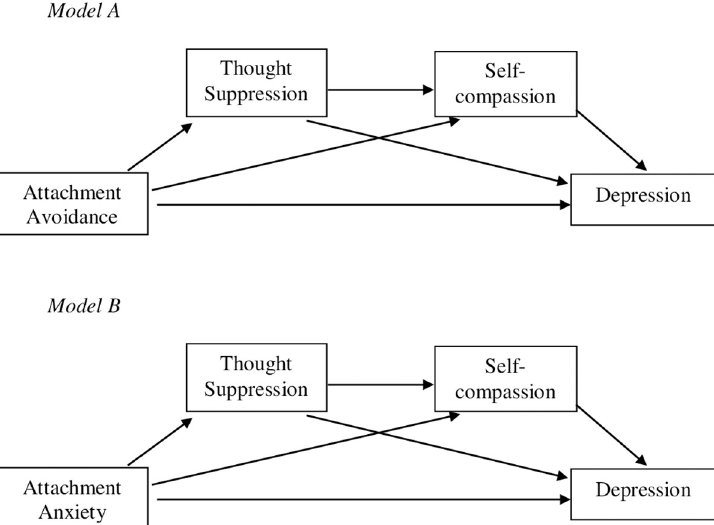
Fig 1. Mediation models. Model A and Model B were assessed using Hayes’ PROCESS model six (2018), evaluating thought suppression and self-compassion as mediators of the relationship between attachment avoidance and depression and the relationship between attachment anxiety and depression